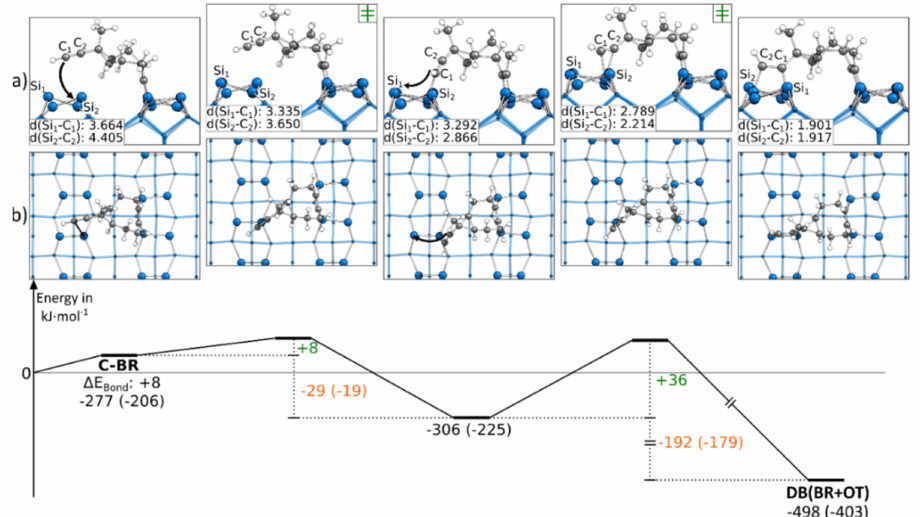
Figure 5. Reaction from a C-BR to a DB(BR+OT) structure, with side ( a ) and top ( b ) views of the minima and transition states. Electronic (Gibbs) bonding energies are stated for the minima. Activation energies ( ∆ E Act ) are shown in green, and electronic (Gibbs) reaction energies ( ∆ E React ) are shown in orange. All values are expressed in kJ · mol − 1 , and Si-C bond lengths are expressed in Å. For both variants of the reaction path, the initial conformer of C-BR is crucial. In all presented reaction paths, the ethinyl group was placed above the neighboring dimer